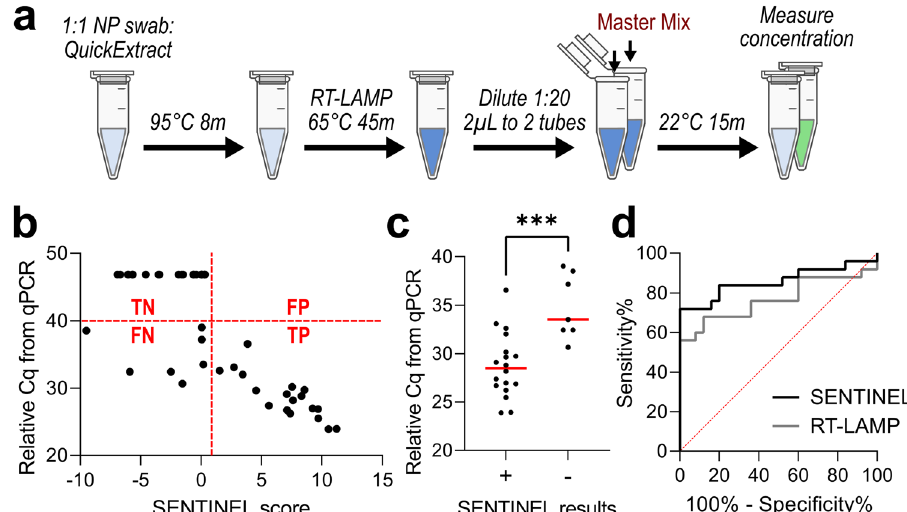
Fig. 5 SENTINEL on 50 blinded nasopharyngeal swabs from patients. a Schematic of SARS-CoV-2 viral particle detection using SENTINEL from patient nasopharyngeal swabs in viral transport media (VTM). b Graph of SENTINEL score versus Cq from qPCR for the 50 blinded patient samples (25 with detectable virus from qPCR — Cq below 40, 25 negative controls — Cq above 40). qPCR Cqs were initially measured from 300 µ L of patient sample, and into True Positives ( ‘ TP ’ ), False Positives ( ‘ FP ’ ), True Negatives ( ‘ TN ’ ), and False Negatives ( ‘ FN ’ ). c True positives with SENTINEL ( ‘ + ’ ) had signi fi cantly lower qPCR Cq compared to false negatives ( ‘–’ ) ( p < 0.001) from Student ’ s t -test. d Receiver operating characteristic (ROC) curves using SENTINEL versus RT-LAMP